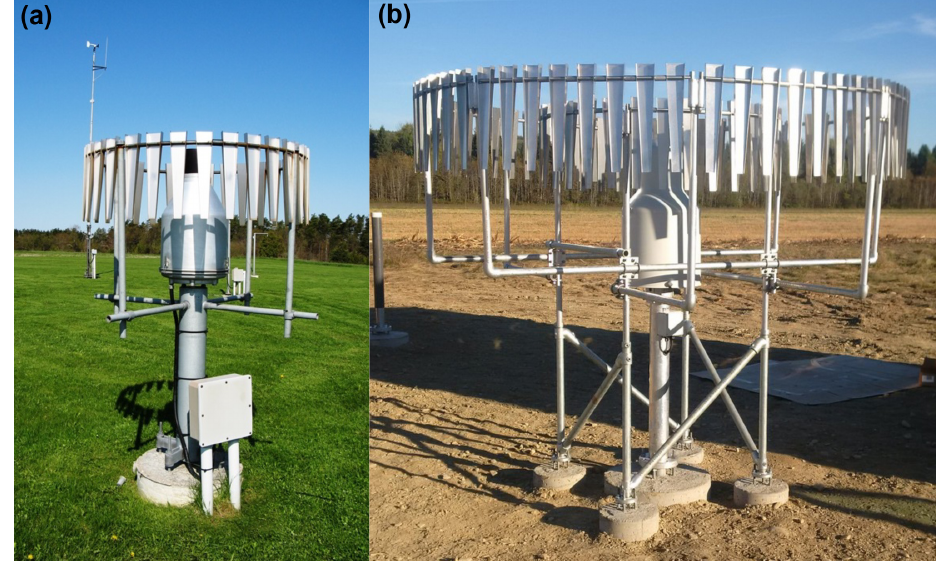
Figure 4. Standard automated precipitation gauge configurations deployed across the ECCC network. Geonor T-200B gauge with single Alter Shield (a) . OTT Pluvio 2 L gauge with double Alter Shield (b)